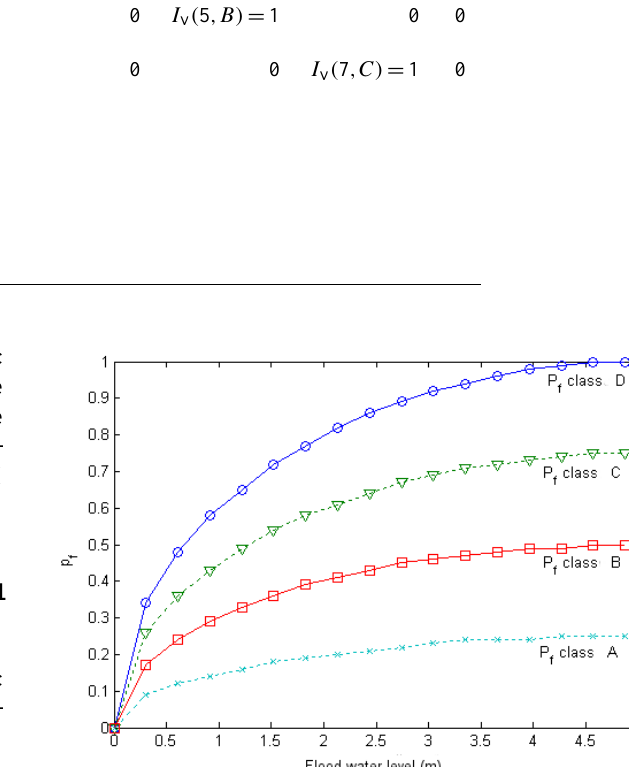
f according to the flood